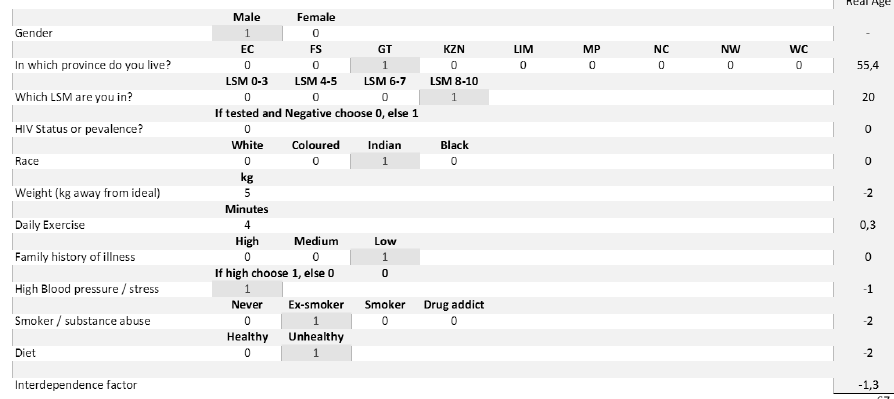
FIGURE 8: Graphical interface showing simulation of Person_Z